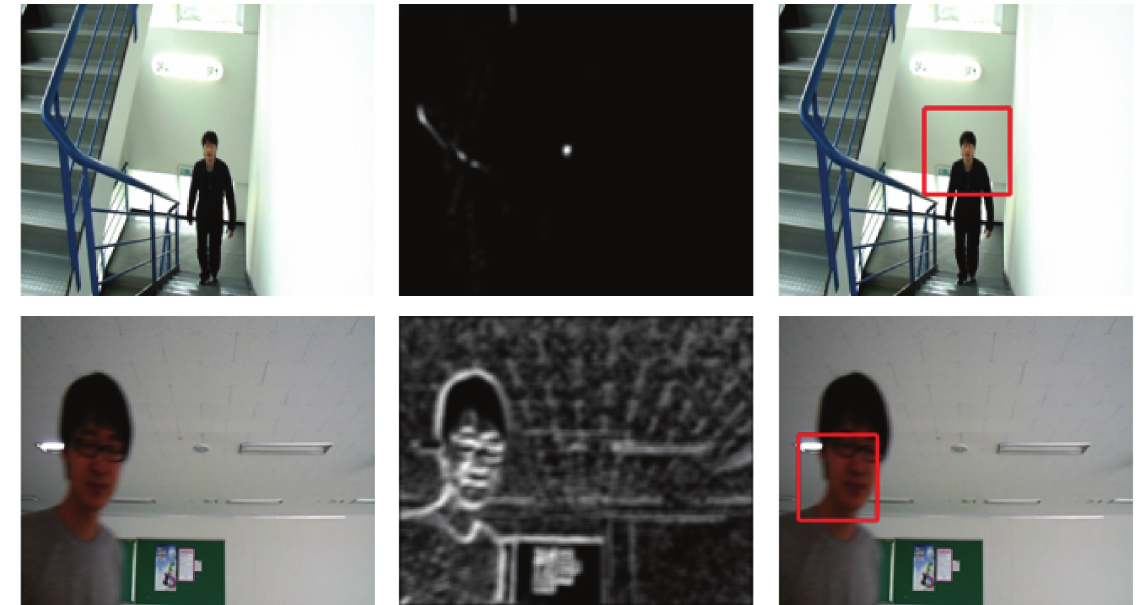
Figure 16: Videos (1) and (2): results using integrating colour saliency with texture feature (local binary pattern (LBP) for different videos.